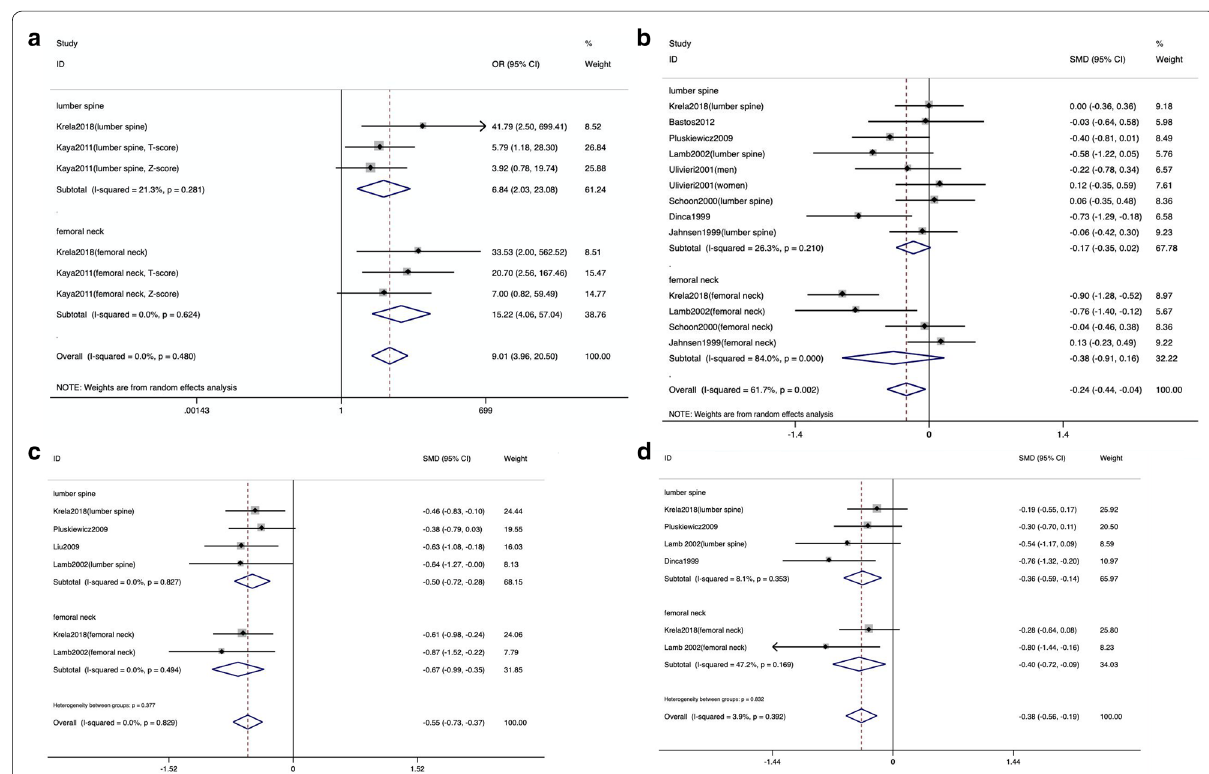
Fig. 4 Subgroup analyses of the association between bone mineral density and ulcerative colitis in the lumbar spine and the femoral neck. A Pooled odds ratio (OR) for the association between low bone mineral density and ulcerative colitis in the lumbar spine and the femoral neck. Three studies did not include the outcomes based on the detection sites separately, so they were excluded from this subgroup analysis. There was no significant heterogeneity in these two subgroups (I 2 21.3%, P 0.281 and I 2 0.0%, P 0.624). B Pooled standardized mean differences (SMDs) for = = = = bone mineral density and ulcerative colitis in the lumbar spine and femoral neck. C Pooled SMDs for the association between t-score and ulcerative colitis in the lumbar spine and femoral neck. One study did not include the outcomes based on the detection sites separately, so it was excluded from this subgroup analysis. D Pooled SMDs for the association between the z-score and ulcerative colitis in the lumbar spine and femoral